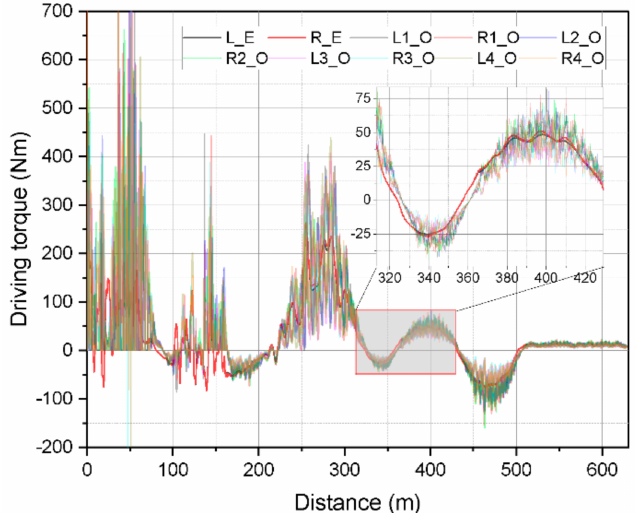
Figure 6. The comparison of tractive torque